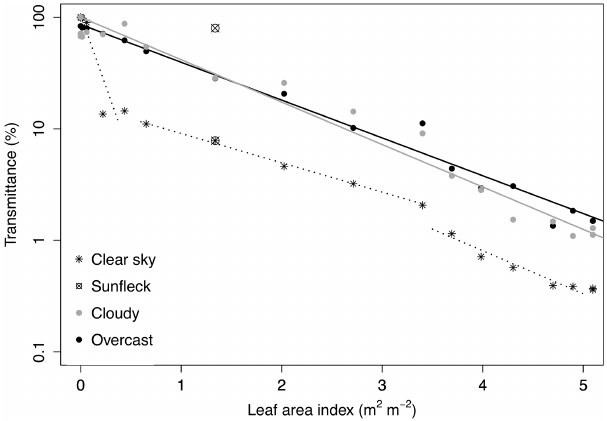
Figure 6. Transmissivity and attenuation curves according to the Monsi and Saeki (1953) method. Transmissivity and light attenua- tion through the forest canopy after applying the Beer–Lambert at- tenuation law. Stars and dotted lines represent clear sky, grey solid circles and the grey line represent cloudy and solid black circles and the black line represent the overcast